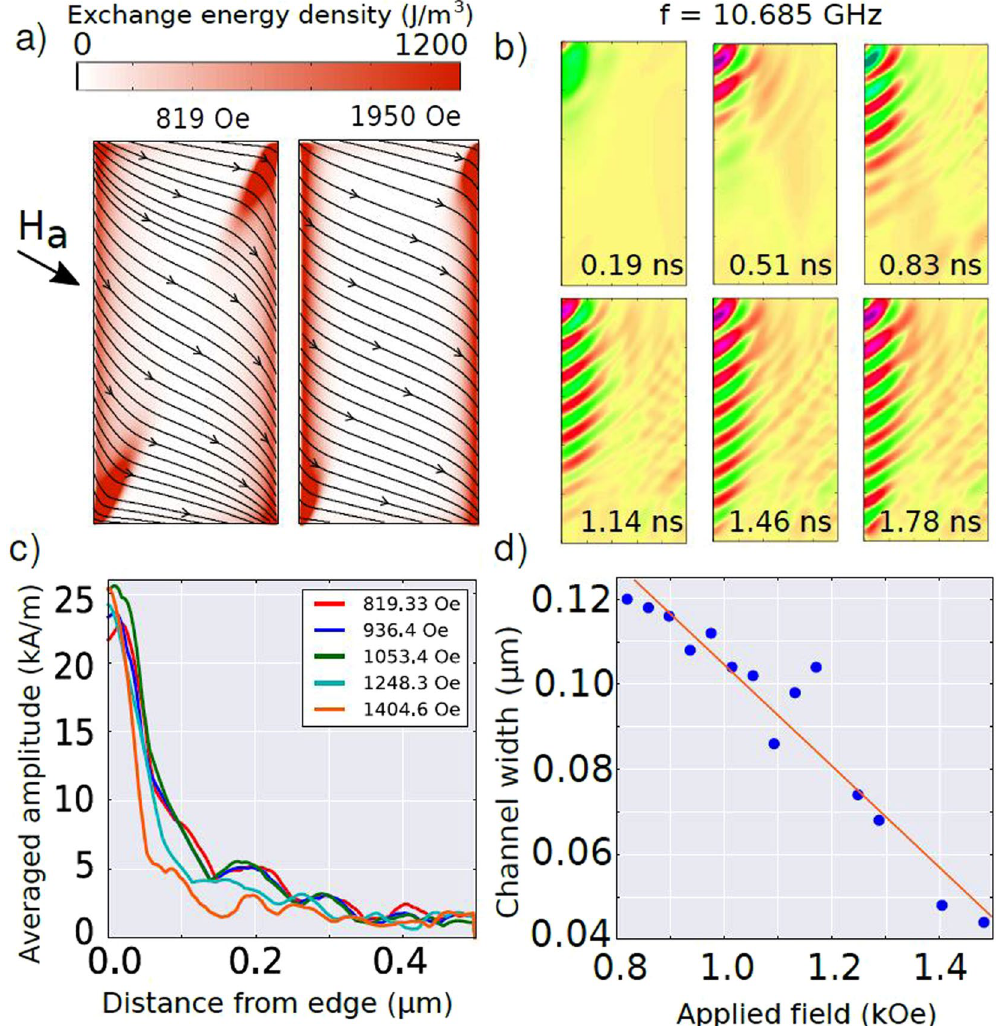
Figure 6. Edge spin waves in 30 nm thick rectangular elements (1 × 0.5 μ m): ( a ) the exchange energy density; ( b ) snapshots of the edge spin waves excited at the top left corner at an applied field 819 Oe, at 20° from the horizontal; ( c ) amplitude of the edge spin waves (averaged over the vertical side of the rectangle) vs. distance from the edge; ( d ) width at half height of the exchange channels vs. magnitude of the applied field at 20° from the